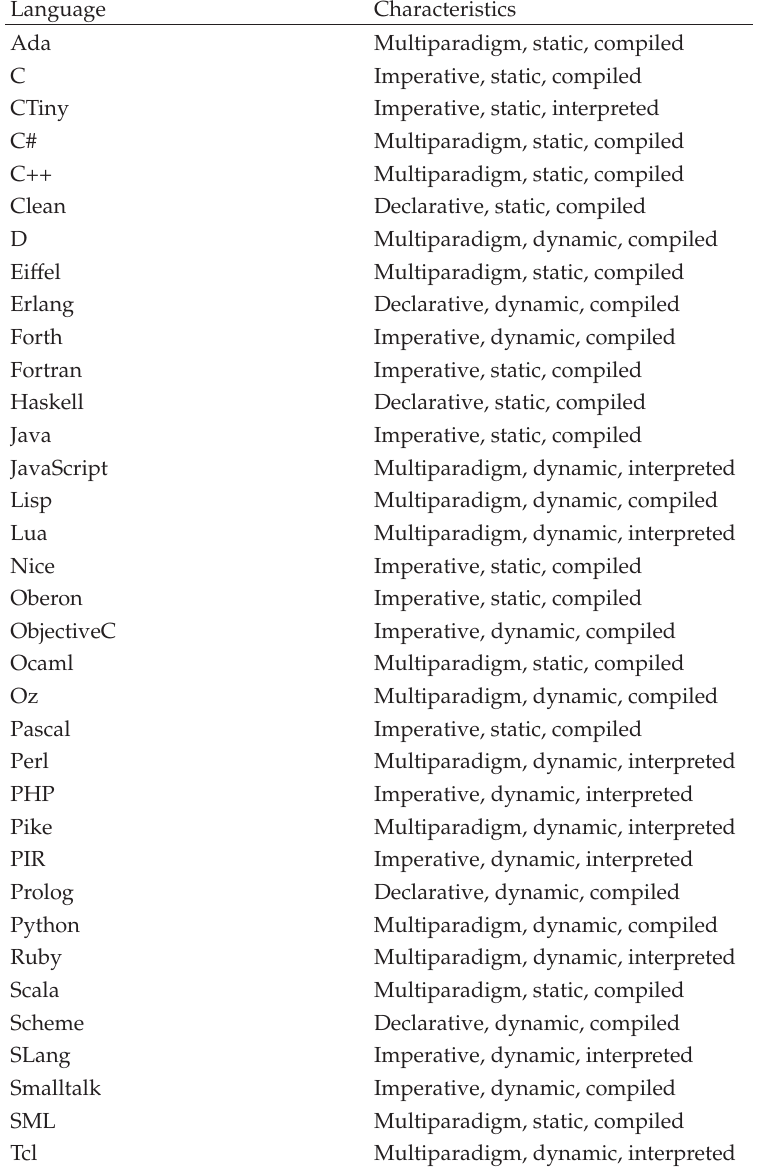
Table 1: Programming languages